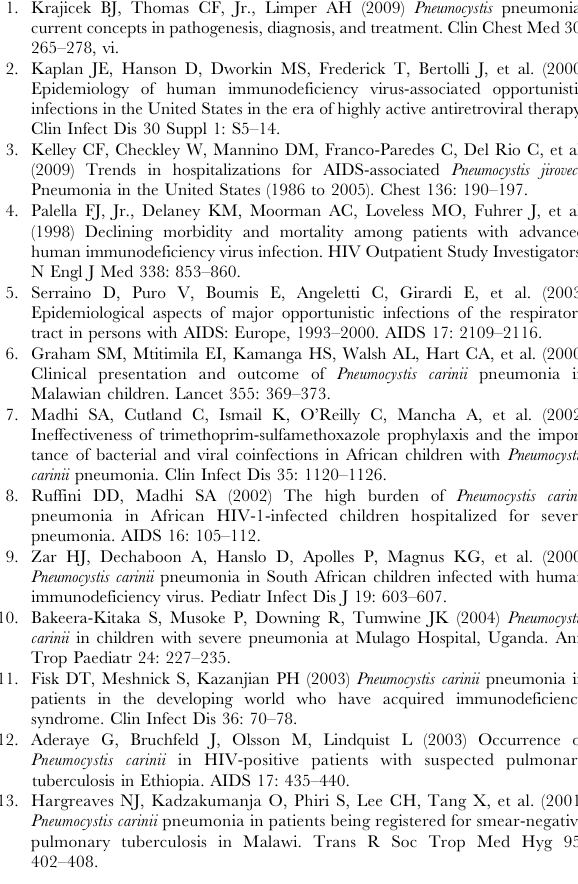
Table S2 Model inputs: Personnel and time requirements and associated costs for laboratory procedures for diagnosis of Pneumocystis pneumonia. ¥Time estimated from starting sample estimated as the amount of time a test takes excluding machine